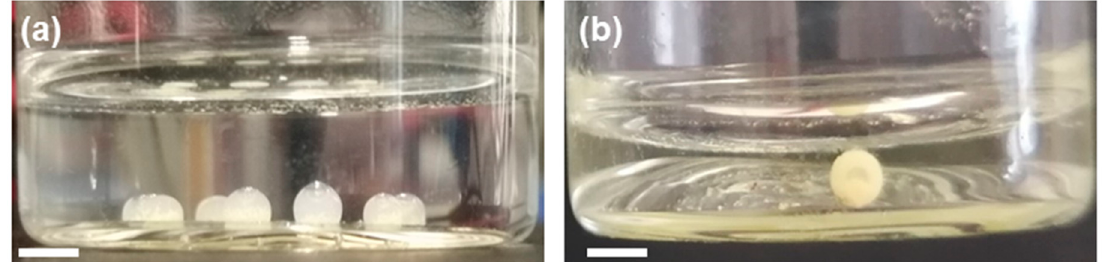
Figure 3. ( a ) Digital image of CMp-vTA/chloroform (CN/TCM) ‘c’-shaped droplets in aqueous PEI solution overnight (side view); ( b ) digital image of CMp-vTA/chloroform (CN/TCM) droplet in aqueous PEI solution at pH = 2 after 3 days (side view). Scale bars correspond to 1 cm.